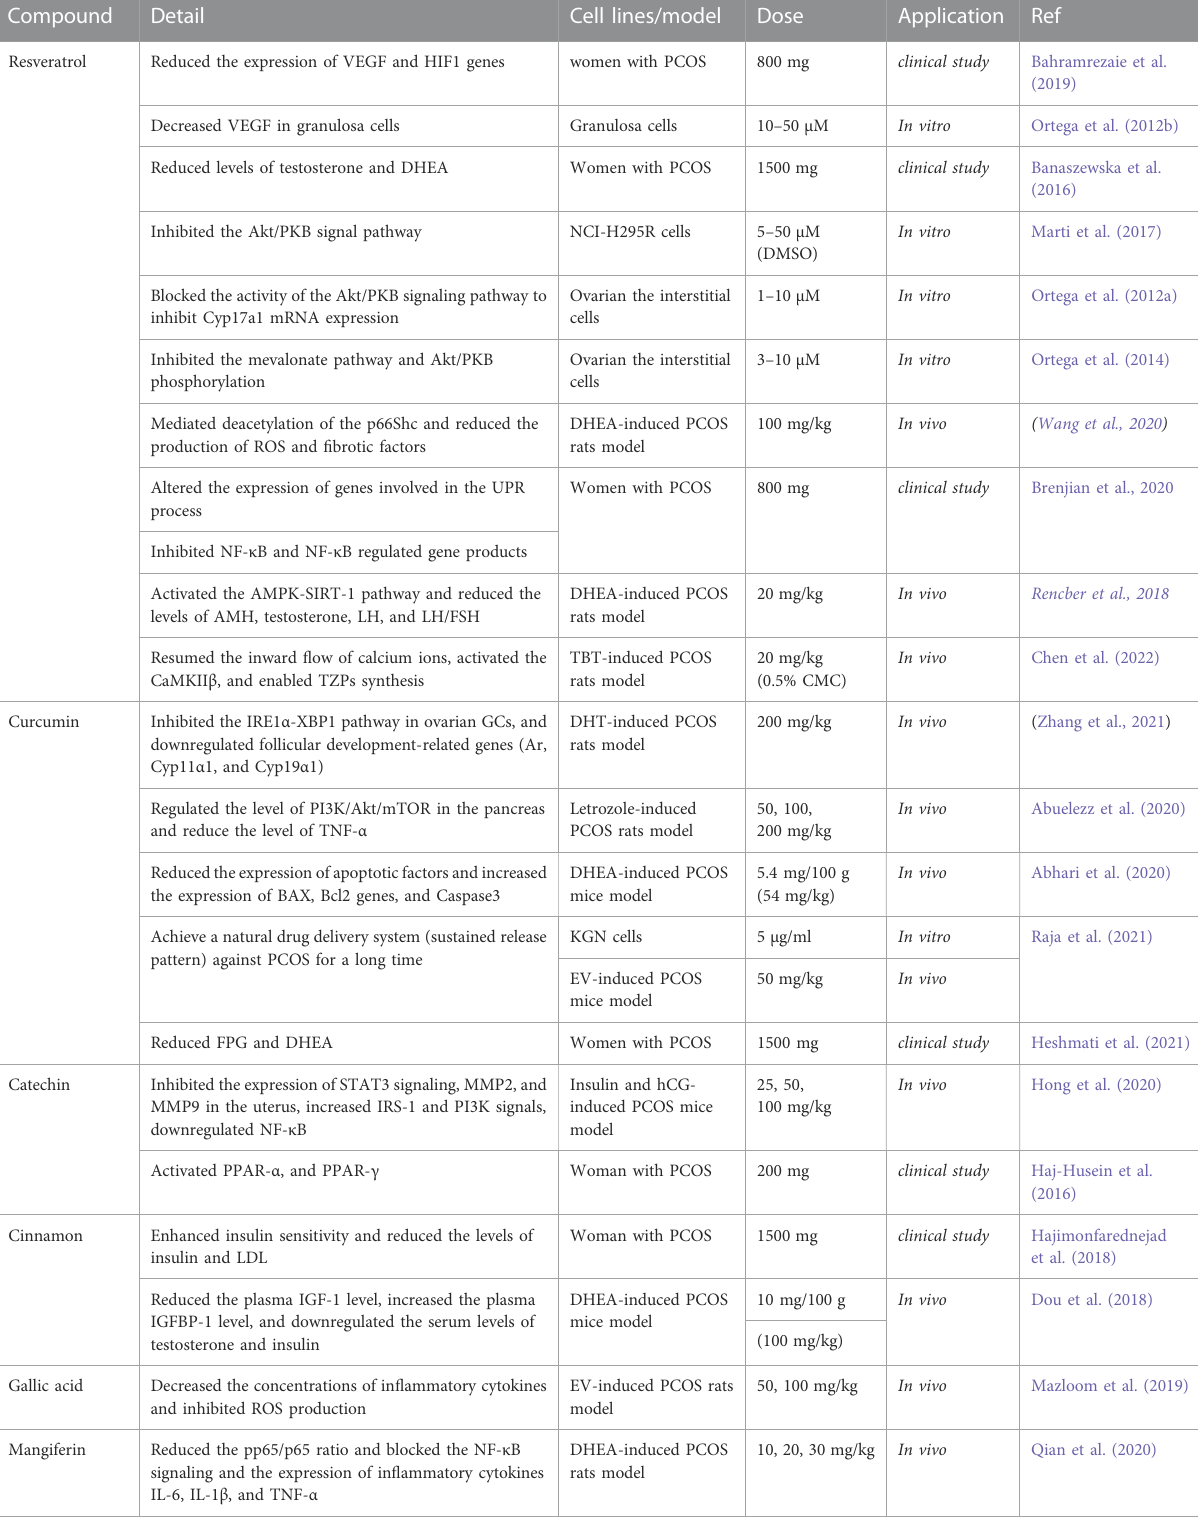
TABLE 2 Therapeutic effects of polyphenols on